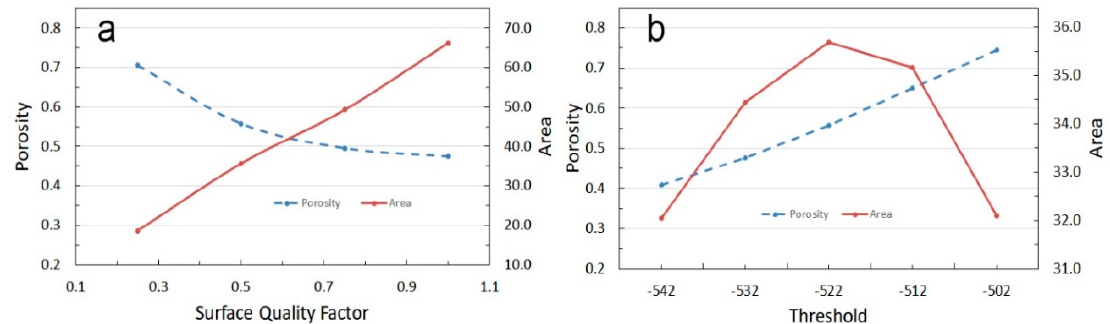
Figure 3. Effects of SQF ( a ) and Threshold ( b ) on surface area and porosity of the reconstructed model.